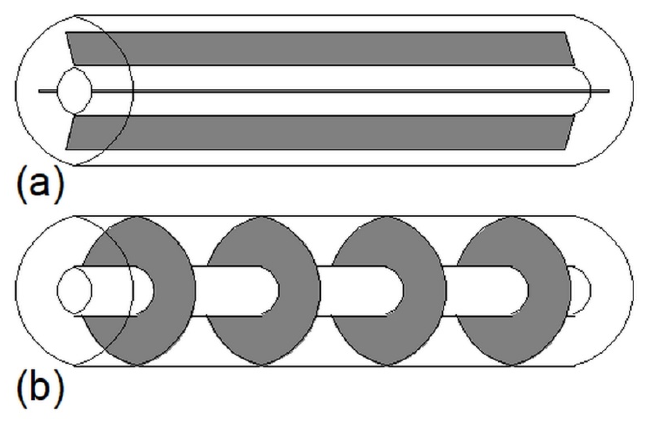
Figure 9. DTHX with: ( a ) Longitudinal fins; ( b ) circular (radial) fins.